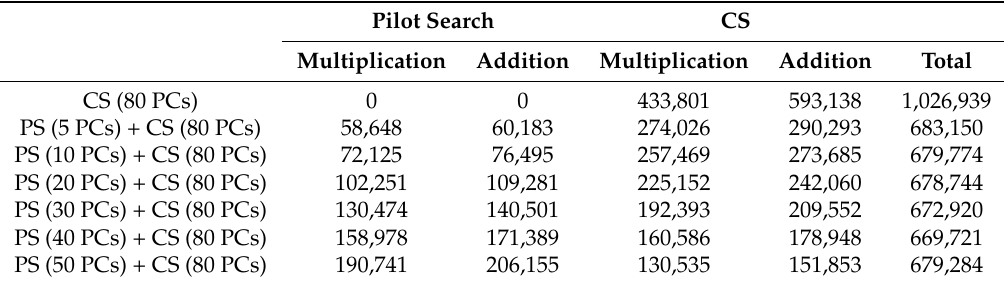
Table 5. Average number of multiplications and additions according to number of PCs.